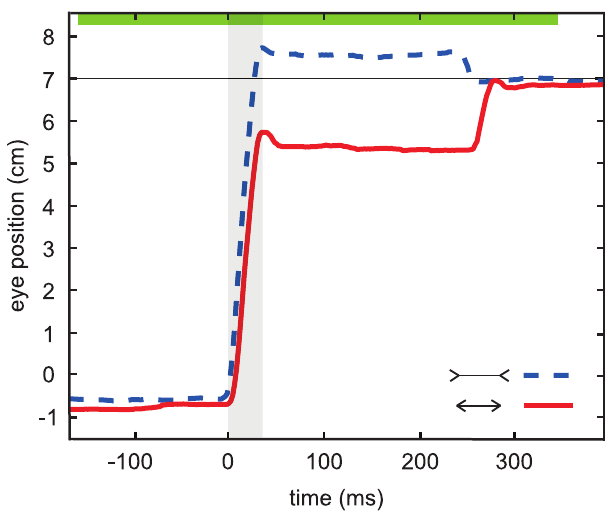
Figure 3. Two examples of saccades in trials in which the participant did not perceive the flash. Both are for a figure with a 7 cm shaft length in the same session. The primary saccade (grey area) is influenced by the illusion. About 220 ms later, a secondary (corrective) saccade brings the eye to the end of the shaft. The fixation cross was at 0 cm, and t=0 corresponds to the onset of the primary saccade. The green bar at the top of the figure represents the time for which the Mu¨ller-Lyer figure is on the screen. doi:10.1371/journal.pone.0062436.g003 the same color). The effects were consistent across participants. The repeated measures analysis of variance on the value of the mislocalisation curve halfway through the saccade showed a significant effect of flash location (F (4,36) = 40.96, p , 0.001) and figure configuration (F (1,9) = 54.97, p , 0.001), as well as a signifi- cant interaction between the two (F (4,36) =6.10, p , 0.001).